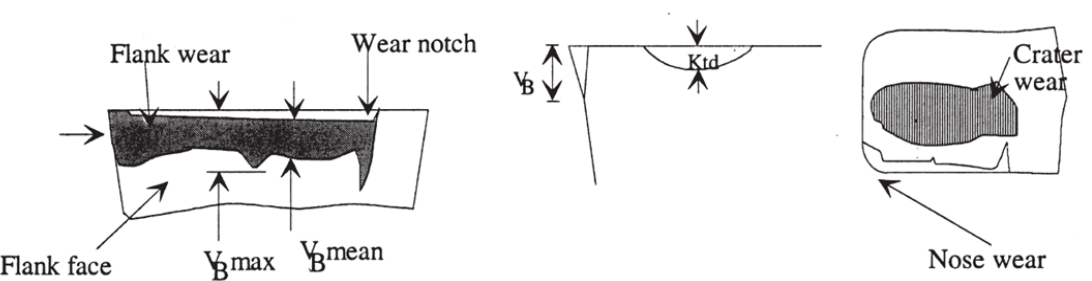
Figure 9. Types of crater wear and flank wear to standard ISO 3685:1993 [99,117]. FW is the type of wear caused by the friction that occurs between the insert clearance angle of the cutting tool and the new surface of the part corresponding to this angle. The width of the FW is indicated by V B . Mechanical, chemical, diffusive seem to be the major load factors affecting the FW [118,119].